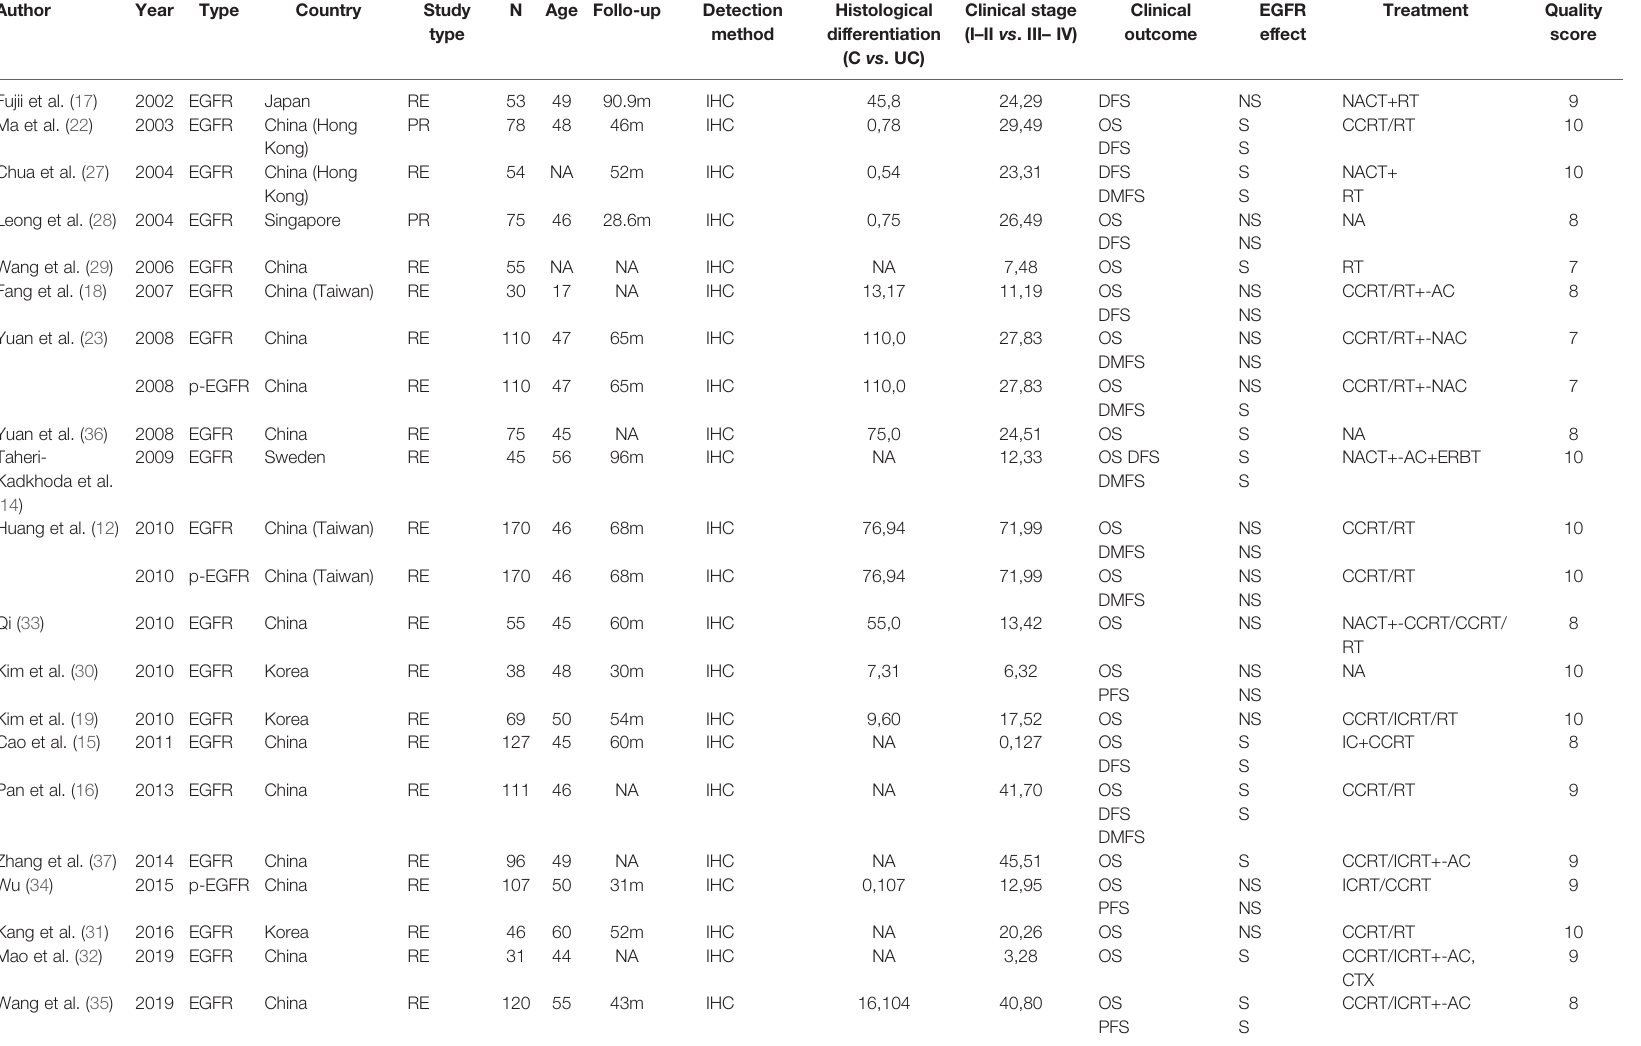
TABLE 1 | Characteristics of included